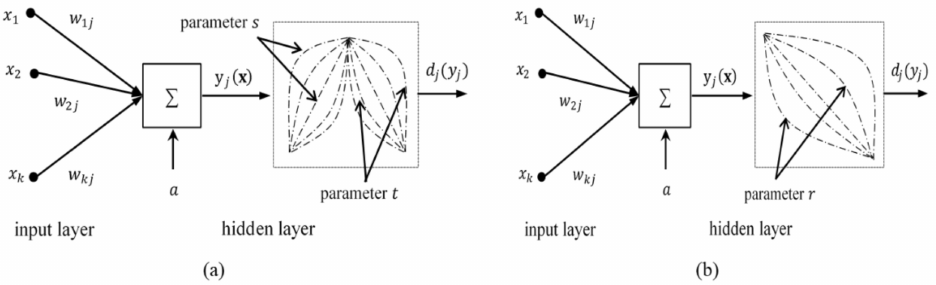
Figure 3. Integration of DFs as transfer functions in hidden layers: ( a ) “nominal is best” transfer function and ( b ) “smaller is better” transfer